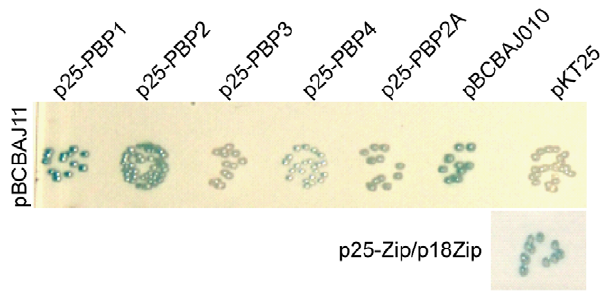
Figure 7. EzrA interacts with PBPs in a Bacterial Two Hybrid assay. Plasmid pBCBAJ011 (encoding EzrA-T18) was co-transformed with plasmid p25PBP1, p25PBP2, p25PBP3, p25PBP4, p25PBP2A, pBCBAJ010 (encoding EzrA-T25) and pKT25 (empty vector, negative control) and a 10 2 2 dilution of each resulting culture was plated. Plasmids p25Zip and p18Zip were used as positive control. Formation of blue colonies indicates putative interaction between cloned proteins, namely between EzrA and itself, PBP1 and